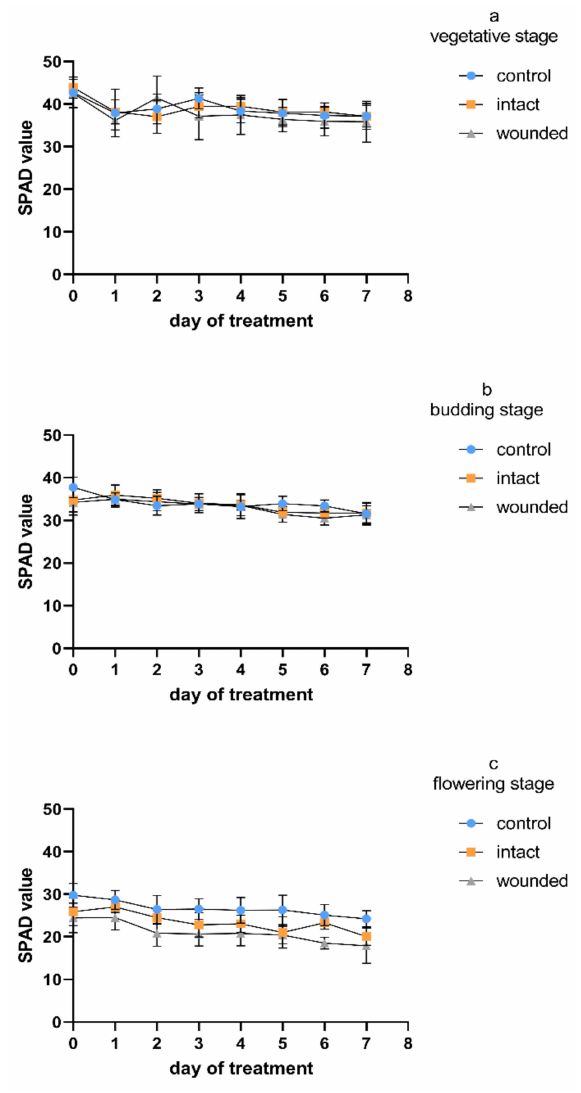
Figure 5. Chlorophyll content of Ocimum basilicum var. minimum L. versus leaf wounding imposed at the ( a ) vegetative, ( b ) budding, or ( c ) flowering stage. Data are means ( n = 21) ± standard deviation